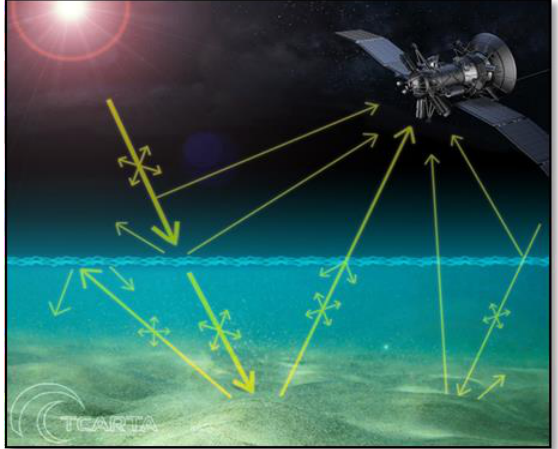
Figure 1. Satellite imagery-derived bathymetry (TCarta,